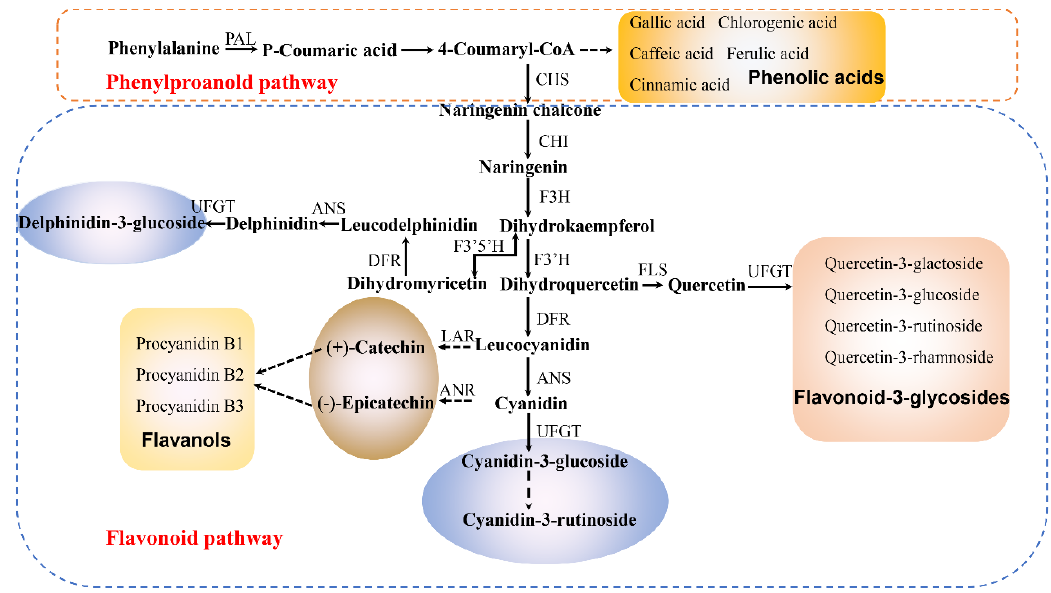
Figure 3. The flavonoid metabolic pathway of the jujube cultivars ‘Tailihong’ and ‘Junzao’. Enzyme names are abbreviated as follows: phenylalanine ammonia-lyase (PAL); chalcone synthase (CHS); chalcone isomerase (CHI); flavanone 3-hydroxylase (F3H); flavonoid 3’-hydroxylase (F3’H); flavonoid 3’,5’-hydroxylase (F3’5’H) dihydroflavonol4-reductase (DFR); anthocyanidin synthase (ANS); flavonol synthase (FLS); leucoanthocyanidin reductase (LAR); anthocyanidin reductase (ANR); UDP glycose: flavonoid 3- O -glucosyl transferase (UFGT). Figure based on reference [29].